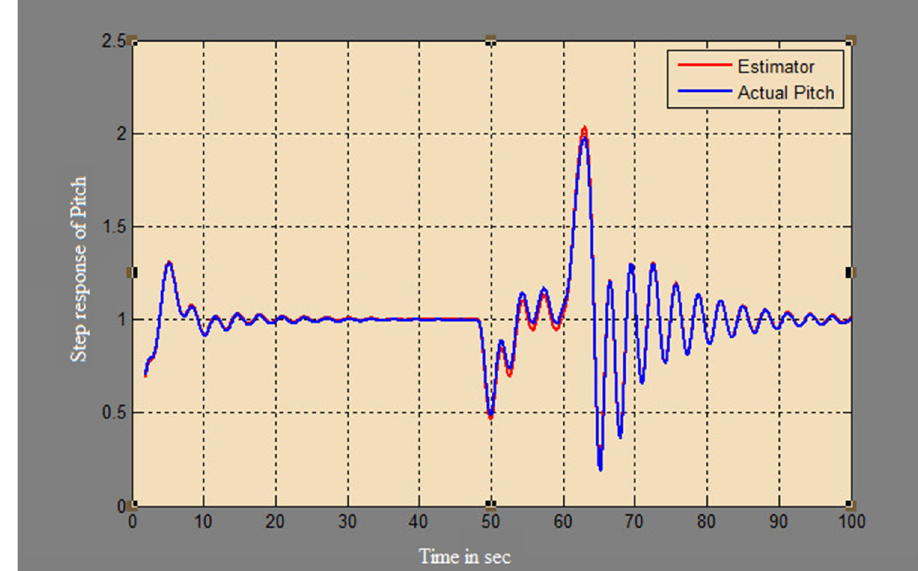
Figure 10. Estimation of a pitch for a step input with a disturbance with Luenberger observer.